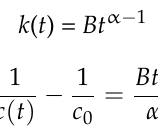
Figure 4. Pulse radiolysis of aqueous solution containing ( a ) 25 mmol dm − 3 OAA, ( b ) 150 mmol dm − 3 PA at various pH, dose per pulse around 60 Gy. Normalized absorbance at λ = 280 nm as a function of time after pulse. Solutions at pH 2 saturated with Ar, at pH 5 and 9 saturated with N 2 O.